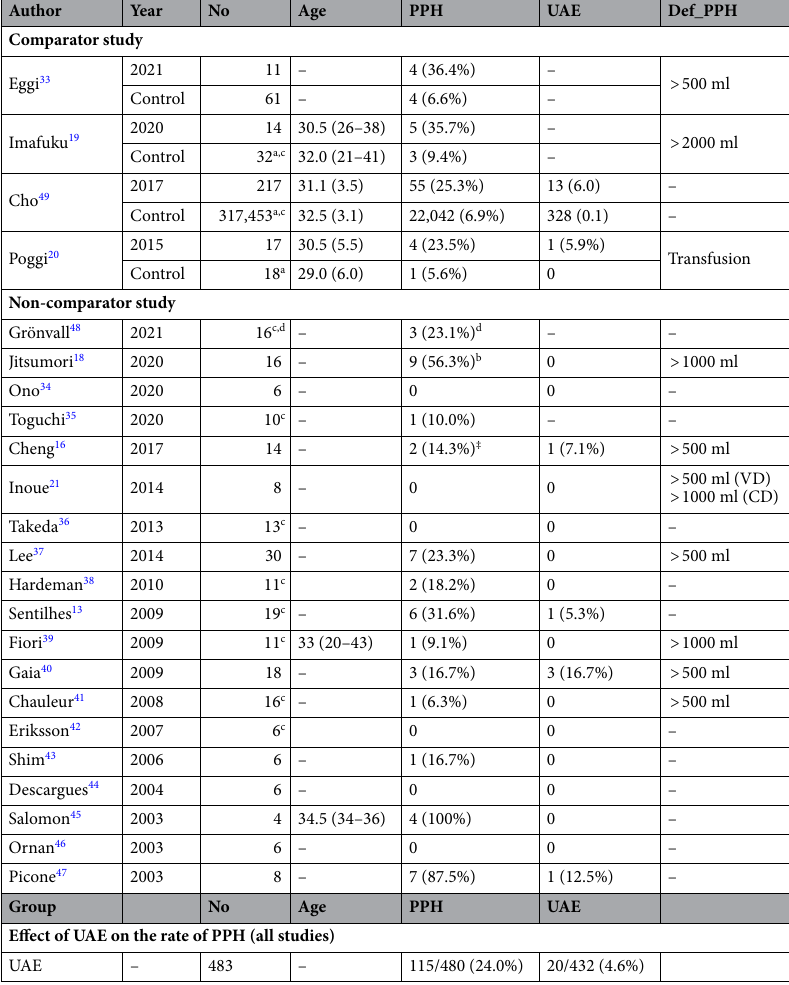
women who did not undergo prior UAE (Fig. 3). Because of the small number of studies examined, the risk of publication bias could not be calculated. According to the adjusted pooled analysis ( n = 1), the rate of hysterec- tomy was higher for women who underwent prior UAE than for women who did not undergo prior UAE (17.6% [3/17] versus 0% [0/18]); however, the difference was not statistically significant ( P = 0.16). To examine maternal outcomes after delivery, rates of urinary tract injury and infection were reviewed. As shown in Supplemental Table S4, the rate of urinary tract injury was reported in one comparator study and three non-comparator studies. No urinary tract injuries were reported for women after UAE ( n = 58). The rate of infection was not reported in the included studies. Risk of PPH. Four comparator studies (three with low quality and one with moderate quality) examined the effect of prior UAE on the rate of PPH during subsequent pregnancies, and 19 non-comparator studies reported the rate of PPH for women who underwent prior UAE (Table 2). Because of the lack of heterogeneity, a fixed- effects analysis was performed. We found three comparator studies investigating 259 women who underwent prior UAE and 317,564 women who did not undergo prior UAE. According to the unadjusted pooled analysis ( n = 4), women who underwent prior UAE were more likely to have PPH (OR 4.72, 95% CI 3.51–6.34; P < 0.01;